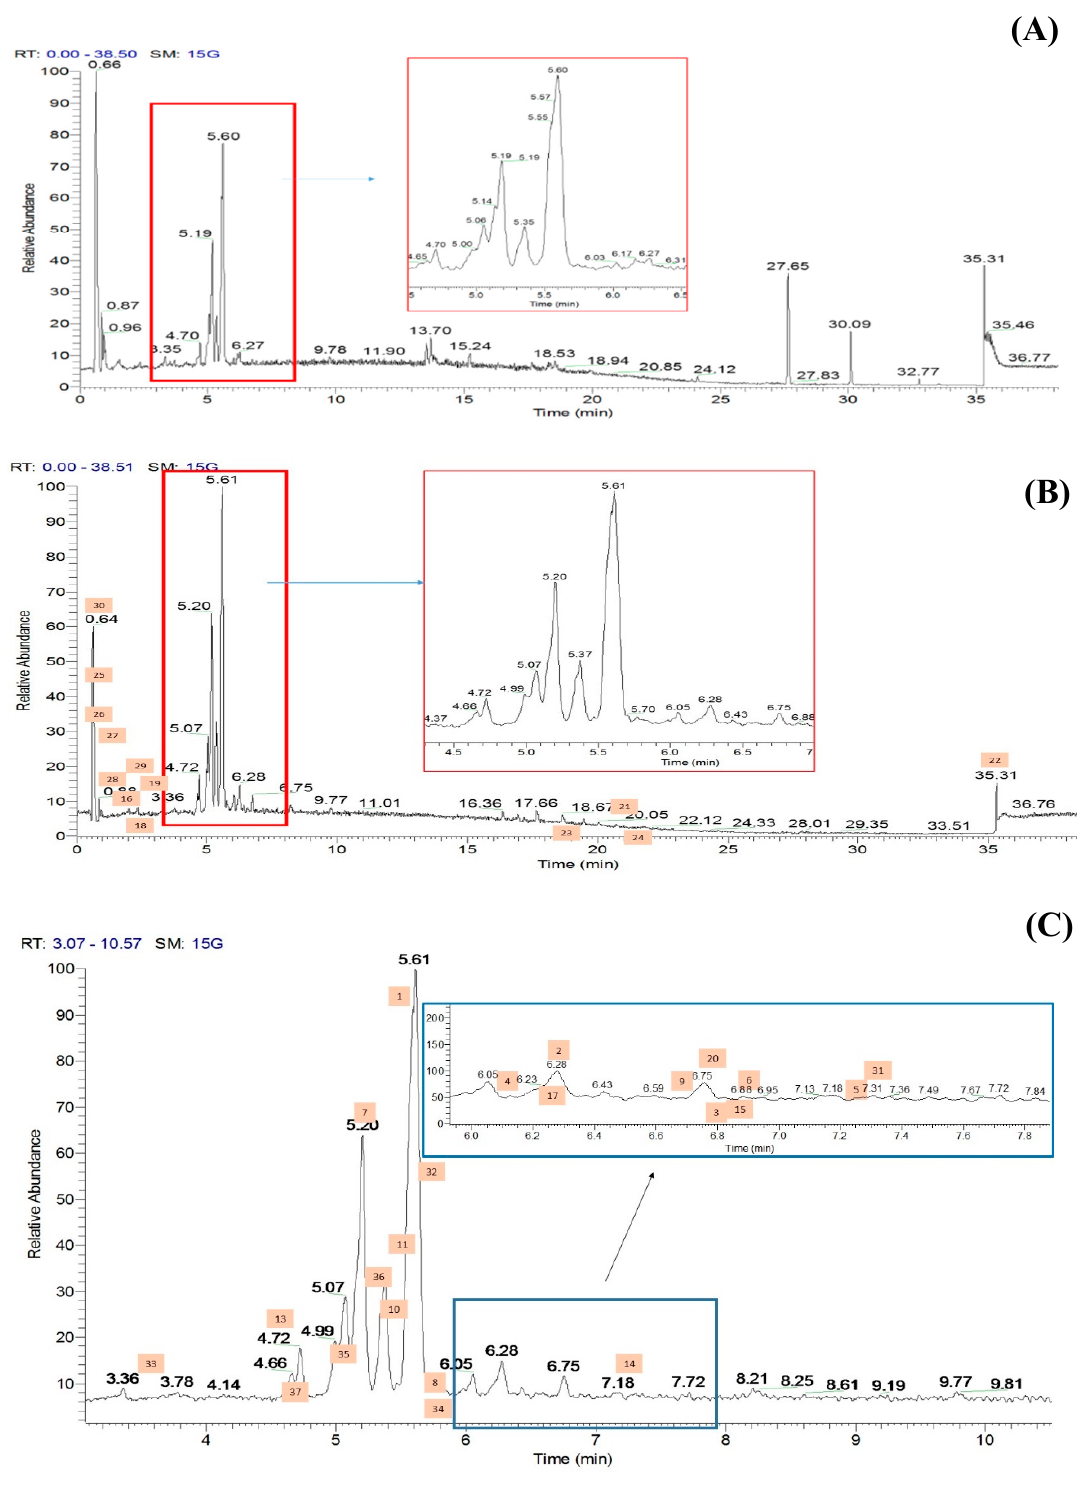
Figure 6. Total ion chromatograms (TICs) of the ethyl acetate fraction of flower methanolic extract of C. ternatea (CTF_EA) in ( A ) positive mode, ( B ) negative mode, and ( C ) negative modes in between 3rd to 10th minutes. The number above each peak represents peak numbers, corresponding to the peak numbers in Table 1.